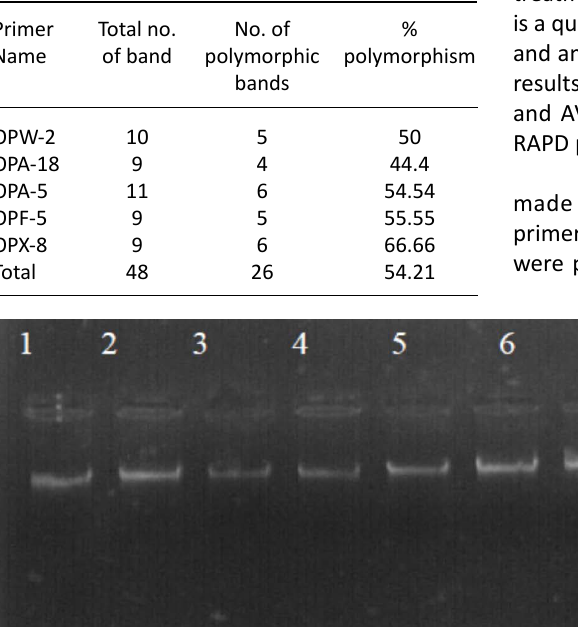
Table 3. The number of amplified products, the number of polymorphic bands, and the percentage of polymorphism obtained using five primers for random amplified polymorphic DNA (RAPD) analysis of fenugreek ( Trigonella foenum-graecum )